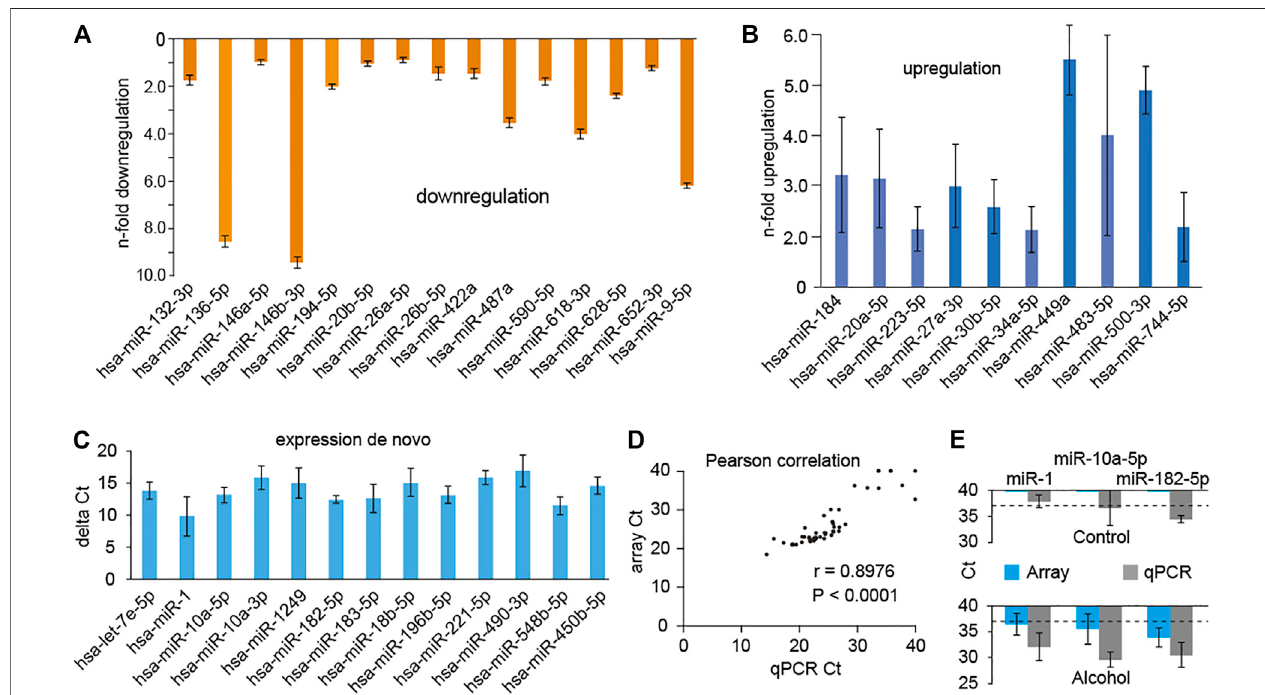
FIGURE1| microRNAspecies,forwhichexpressionissigni fi cantlychangedinthesalivaofalcoholabusers( n (cid:2) 22)comparedtonon-abusingcontrols( n (cid:2) 15). (A) microRNAs downregulated compared to the control group. Expression levels are expressed as n-fold change. (B) microRNAs upregulated compared to the control group.Expressionlevelsareexpressedasn-foldchange. (C) microRNAspeciesupregulated denovo ,meaningthesemicroRNAswereundetectedinthecontrolgroup, but present in the alcohol-abusing group. Lack of expression in controls prohibits comparison of expression levels of these microRNAs between both groups, therefore results are presented as Δ Ct of the alcohol abuser group. (D) High ( r (cid:2) 0.8976) correlation between microRNA microarray results and individual microRNA quantitative PCR (qPCR) results. (E) Validation of de novo upregulation of microRNAs in alcohol abusers. Representative microRNAs indicate borderline expression levels in controls, while detectable in alcohol abusers by both, arrays and qPCR. Note: microRNAs are named according to conventional nomenclature in which mature microRNAs coming from the complementary strands of a precursor are called miR-xx-5p and -3p, respectively, not miR-xx and miR-xx*. Signi fi cance determined using Mann-Whitney U test with p < 0.05. Bars represent the mean ± SEM (Standard Error of the Mean). U6 was used as a